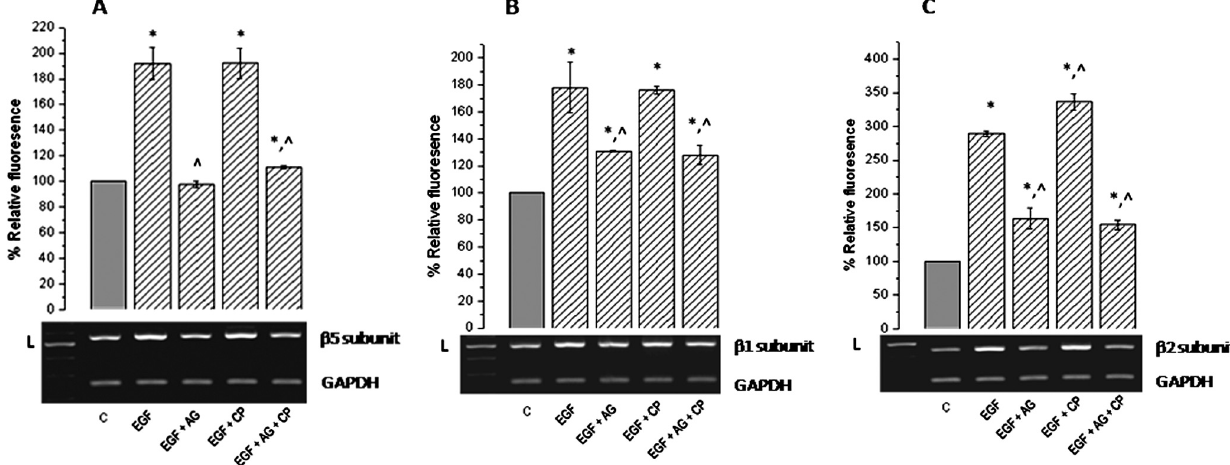
Figure 3. The effect of EGF on gene expression of (A) β 5, (B) β 1, and (C) β 2 catalytic proteasome subunits, respectively, in DLD-1 colon cancer cell line. The mRNA levels are assessed by end-point PCR analysis. Cancer cells are incubated with AG1478 (1 μΜ ) and CP- 724,714 (1 μΜ ) for 30min, followed with the introduction of EGF (20 ng/mL). Total incubation time was 24 h. The percentage of relative fl uorescence of the gene of interest/the reference gene (GAPDH) is given in all of the diagrams. Statistically signi fi cant differences compared with control or EGF-treated cells are symbolized with * p < 0.05 or ^ p < 0.05, respectively. All treatments are given as abbreviations. C: control cells, EGF: Epidermal growth factor (20 ng/mL) AG: AG-1487 EGFR inhibitor (1 μΜ ), CP: CP-724,714 HER2 inhibitor (1 μΜ